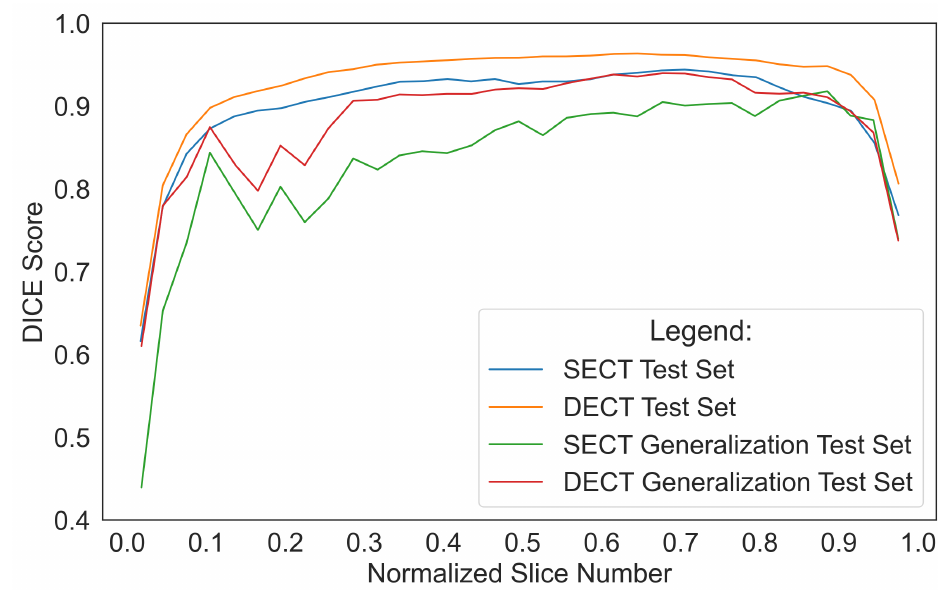
Figure 5. DICE Score per Slice. Line plot shows the normalized DICE score per slice for all scans in the single and synthetic dual energy CT (SECT; DECT) held-out and generalization test sets. The largest errors by the 3D u-net were at the beginning and end of each test